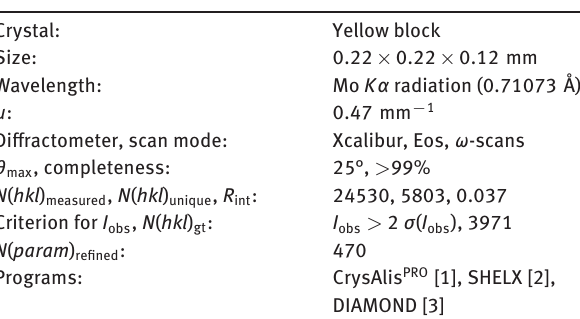
Table 1: Data collection and